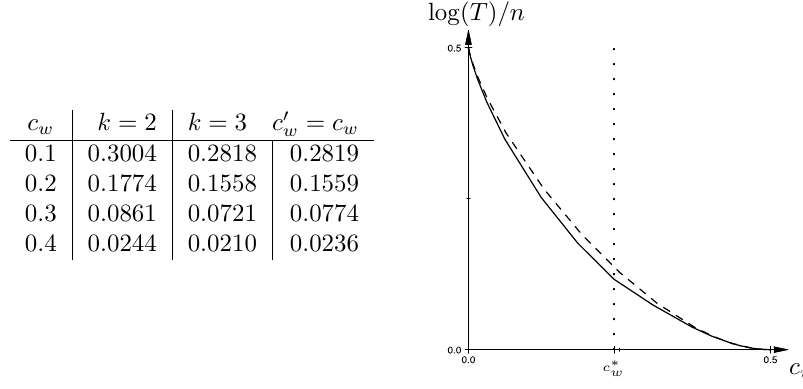
of the approximate 3-list algorithm (solid) compared n